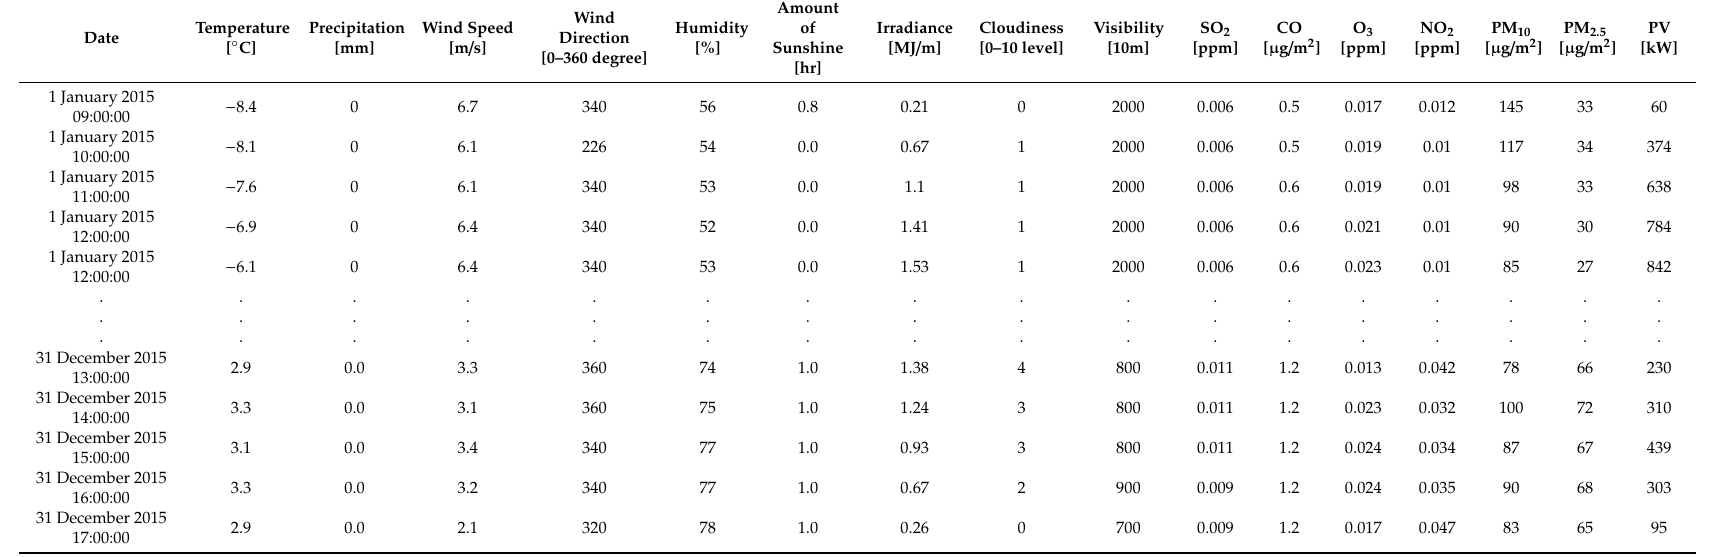
Table 1. The sample of the numerical